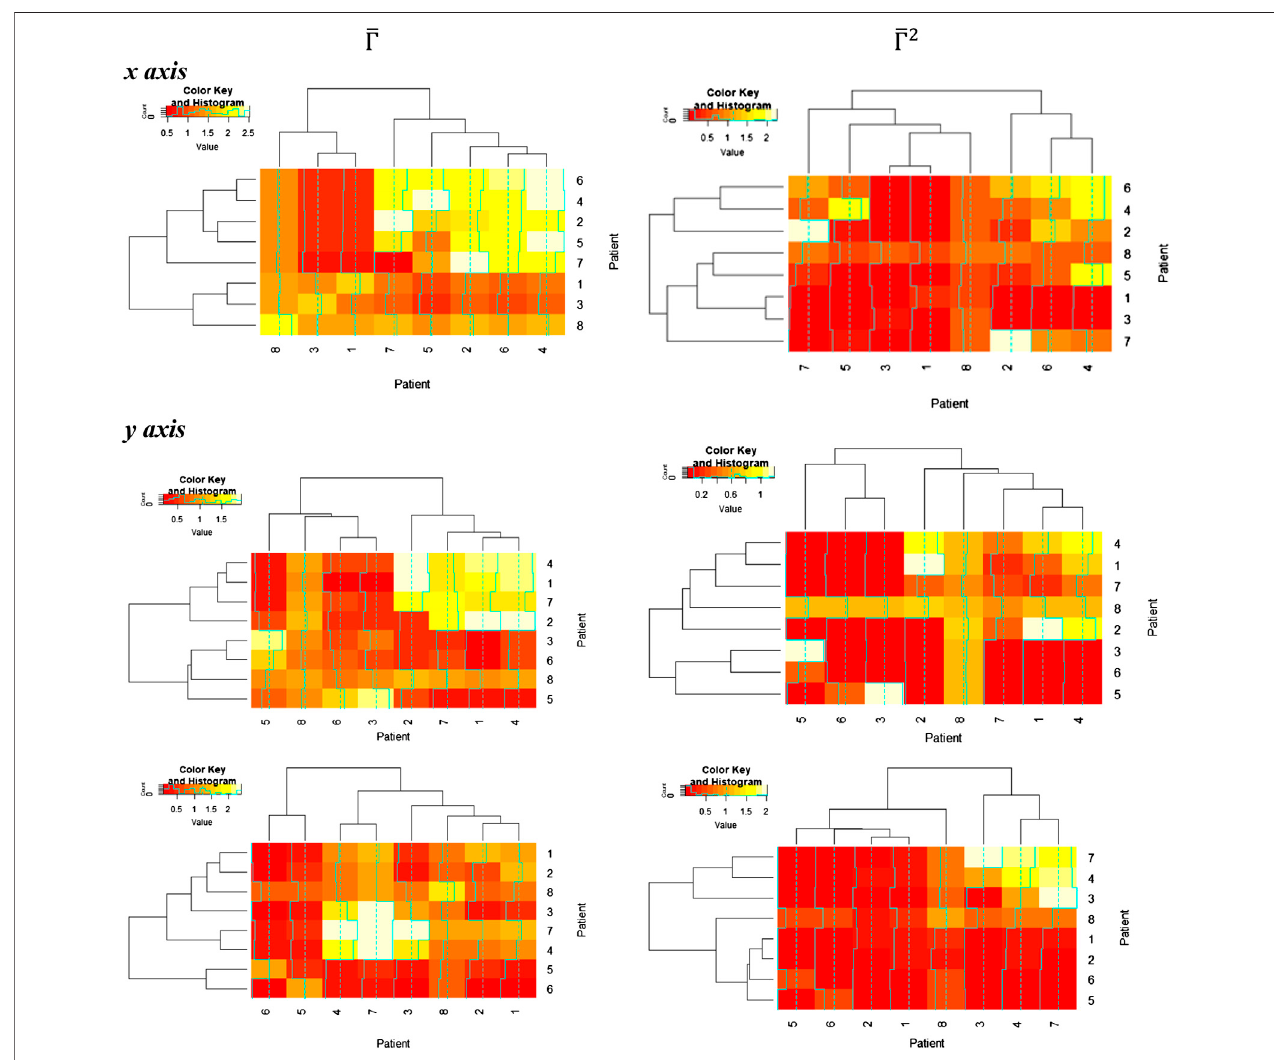
FIGURE 7 | Persistent entropy S ( Γ kl ) and S ( Γ kl 2 ) for Γ k ECG ( t ) and Γ k accel , i ( t ) on the respective axis i ( i (cid:2) { x , y , z })